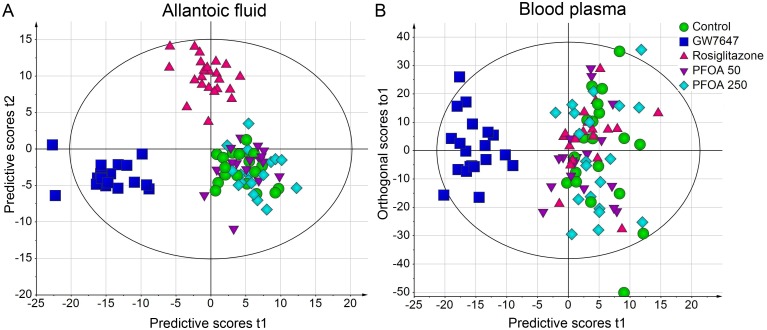
OPLS-DA score scatter plots of metabolites in (A) allantoic fluid and (B) plasma.